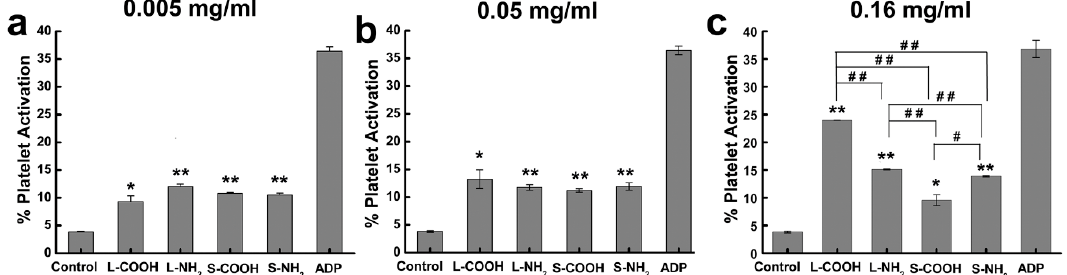
Figure 9. Platelet activation induced by four different types of functionalized CNTs, including long (L) and short (S) MWCNTs at different concentrations: 0.005 mg/ml ( a ), 0.05 mg/ml ( b ) and 0.16 mg/ml ( c ). Dose-dependent platelet activation was observed. At the highest concentration ( c ), long L-COOH and L-NH 2 induced higher level of platelet activation than S-COOH and S-NH 2 , respectively. *: significant difference from the negative control (*p<0.05, **p<0.01); #: significant difference between the indicated MWCNTs (#p<0.05, ##p<0.01). Reprinted with permission from [166].